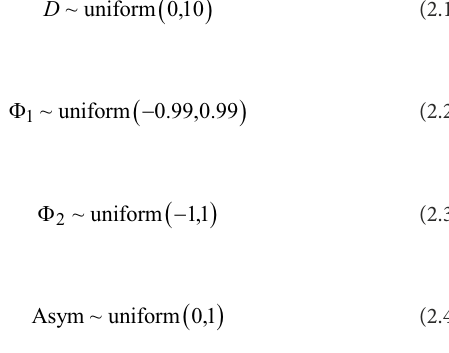
region between 5 ′ CS and 3 ′ CS of class 1 integron in the extracted DNA was inspected via PCR followed by long-read sequencing with ONT. For each Site, extracted DNA from nine different sampling dates was chosen (Supplementary Table S1). A volume of 2 μ l of DNA template was used in 22.5 μ l RedTaq 1.1 × (VWR, PA, United States), 0.5 μ l each of primers 5 ′ CS and 3 ′ CS (both at 10 μ M, Supplementary Table S3). The PCR program was: 95 ° C for 2 min, [95 ° C for 30 s, 55 ° C for 60 s, 72 ° C for 60 s] × 35, 72 ° C for 5 min. For Sites 1 and 2, no PCR product was